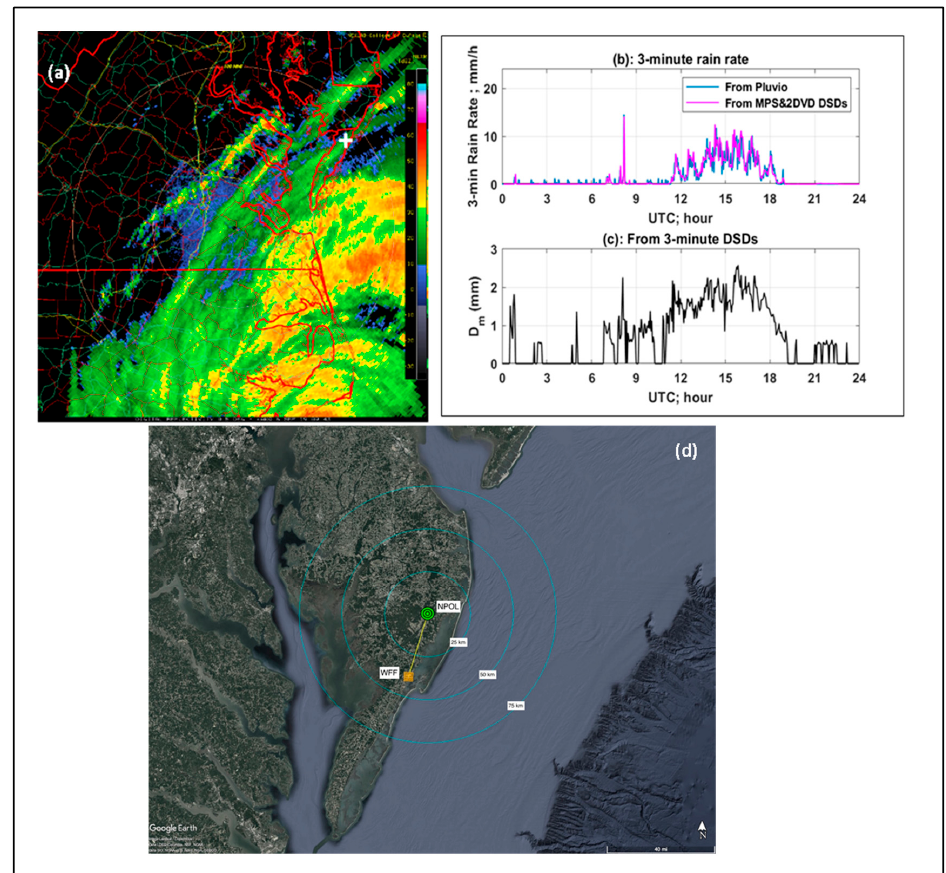
Figure 1. ( a ) Composite radar image of rainbands of Category 1 hurricane Dorian over Wallops ground instrumentation site (white cross) at beginning of storm on 6 September 2019; ( b ) 3 min rainfall rate from Pluvio gauge and from combined disdrometer drop size distribution (DSD); ( c ) mass-weighted mean diameter from 3 min combined DSDs; ( d ) NPOL radar and disdrometer location.